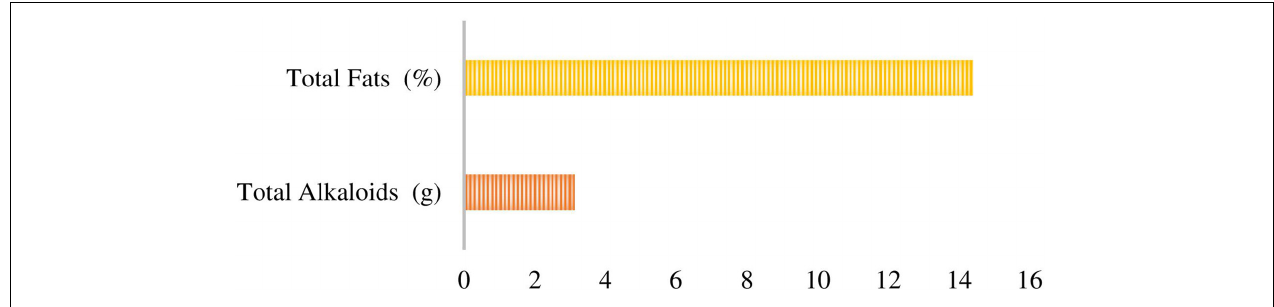
FIGURE 2 | A cluster bar showed the total Fat and Alkaloid contents.